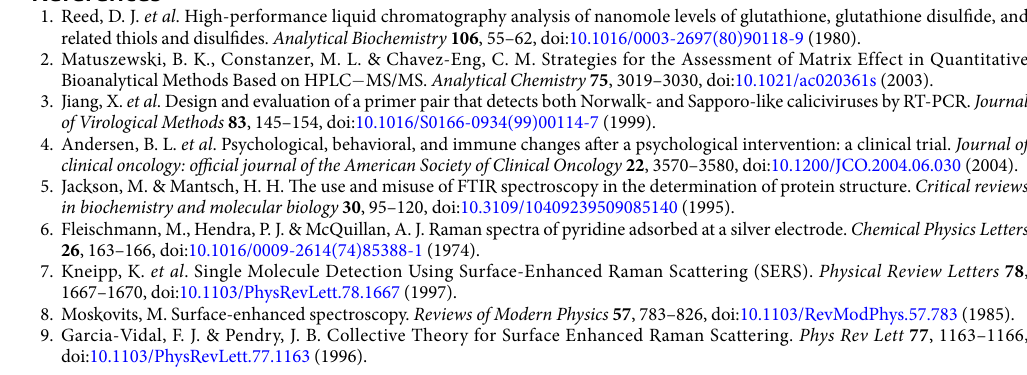
6 Scientific RepoRts | 7: 4604 | DOI:10.1038/s41598-017-04062-4